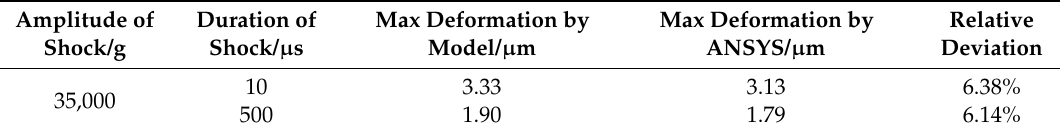
Table 3. Maximum deformation of the inductor with auxiliary pillar as calculated by ANSYS and the proposed model.